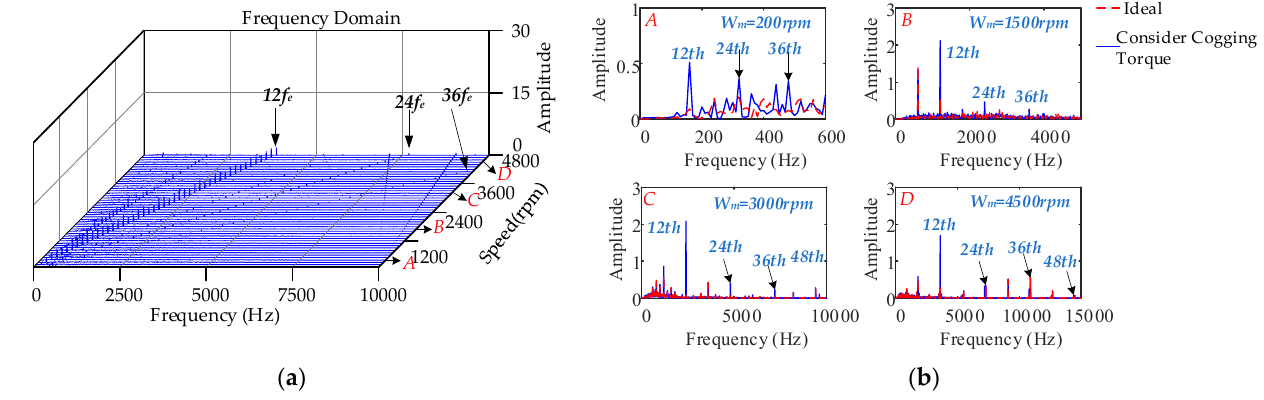
Figure 18. Frequency domain results of electromagnetic torque under different speeds: ( a ) waterfall diagram of electromagnetic torque; ( b ) comparison results of electromagnetic torque.